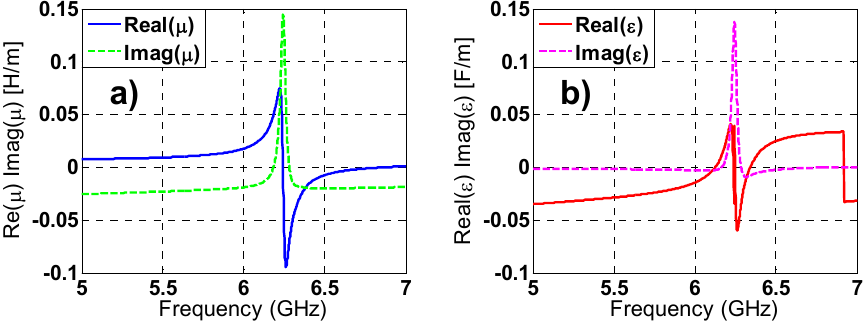
Figure 11. TE polarization: ( a ) real and imaginary parts of magnetic permeability; ( b ) real and imaginary parts of electric permittivity.